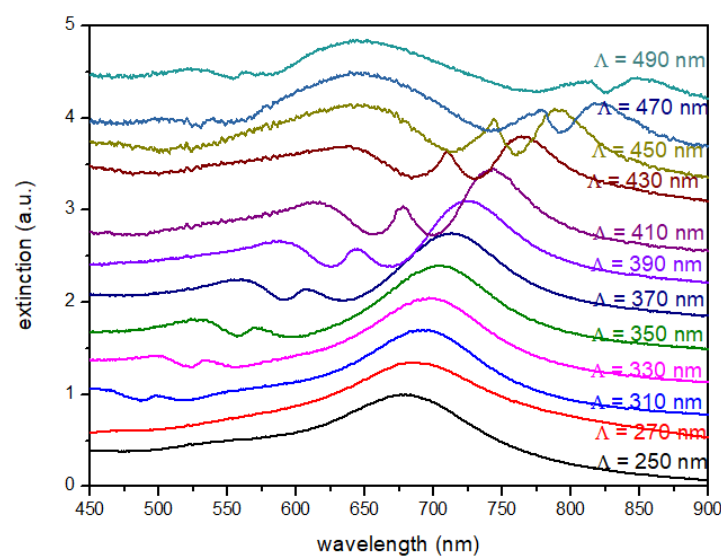
Figure 7. Extinction spectra recorded in oil (in transmission and normal incidence) for square arrays of gold nanodiscs with a diameter D = 100 nm. The grating constant varies from Λ = 250 to 490 nm. The height of nanodiscs is fixed to h = 50 nm.